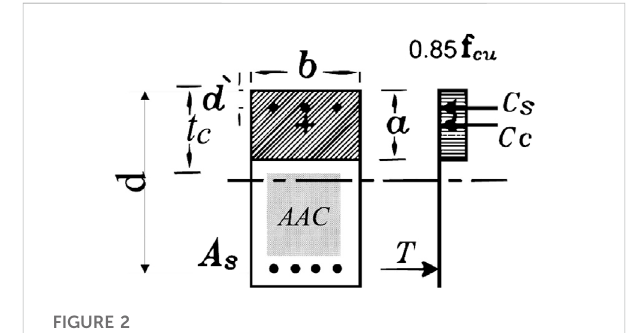
FIGURE 2 Internal forces on the composite